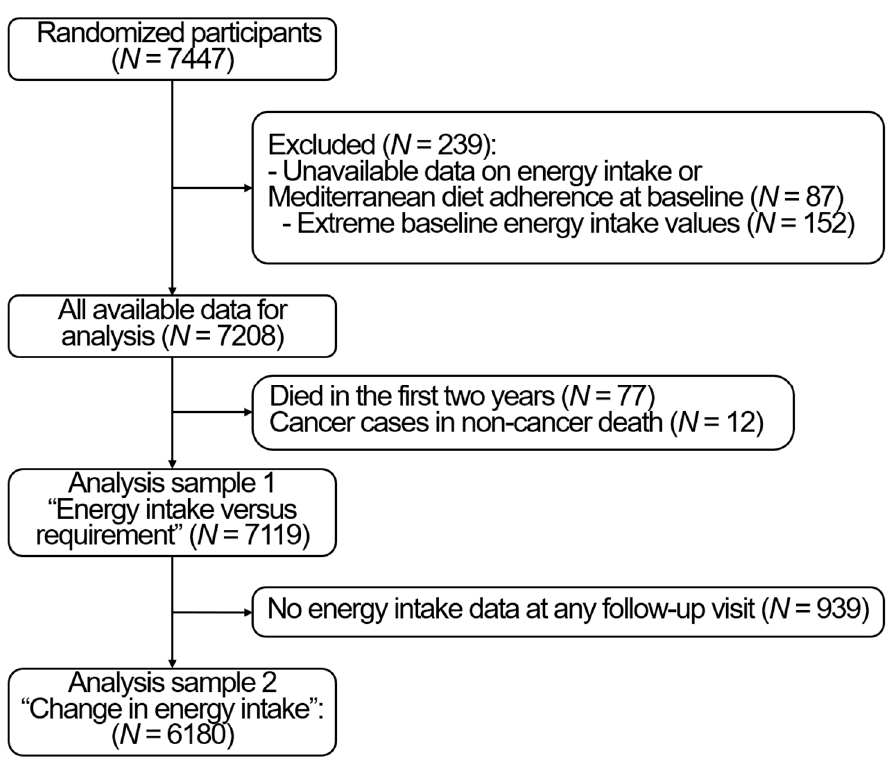
Figure 1. Study flow